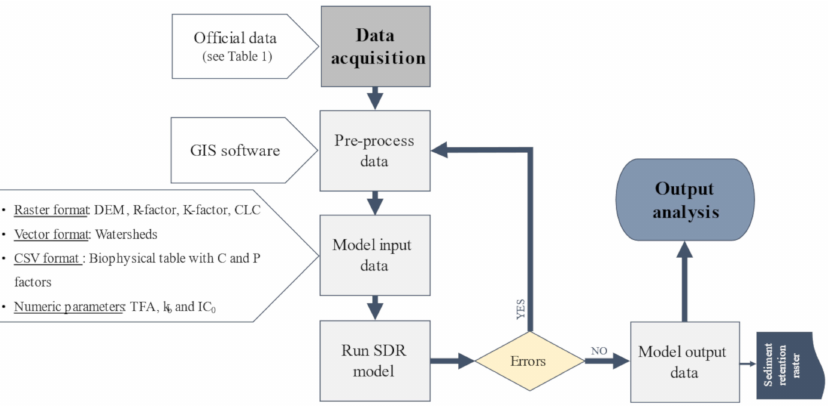
Figure 2. Sediment delivery retention model